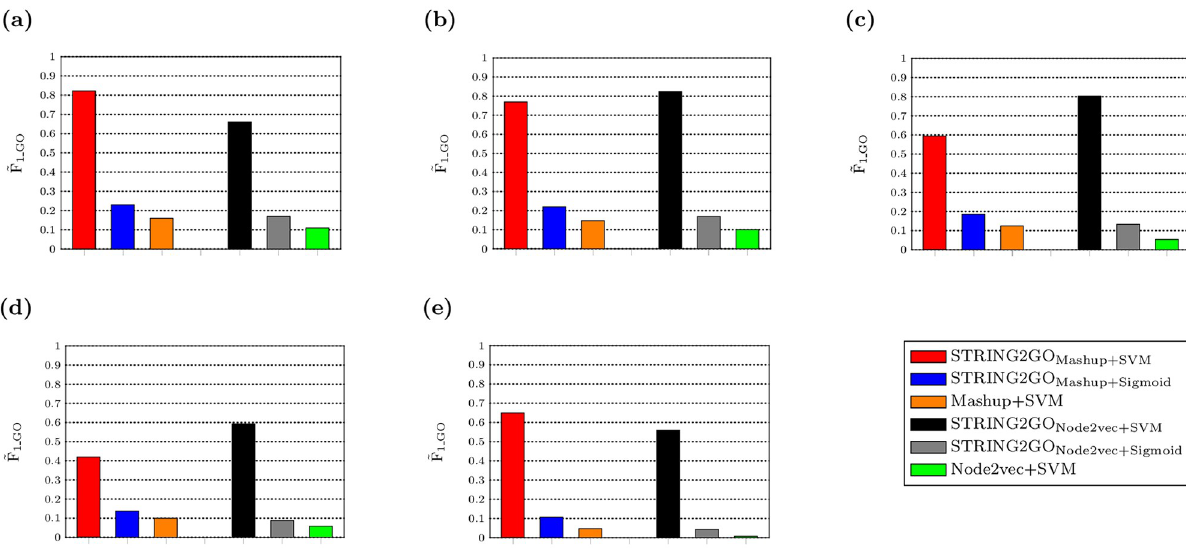
Fig 2. ~ F scores obtained by network embedding representations and the corresponding STRING2GO-learnt functional representations based 1 GO on (a) Combinedscore, (b) Textmining, (c) Experimental, (d) Database and (e) Coexpression networks by using SVM or Sigmoid function over the 10-fold cross validation during the GO term-specific classifiers training